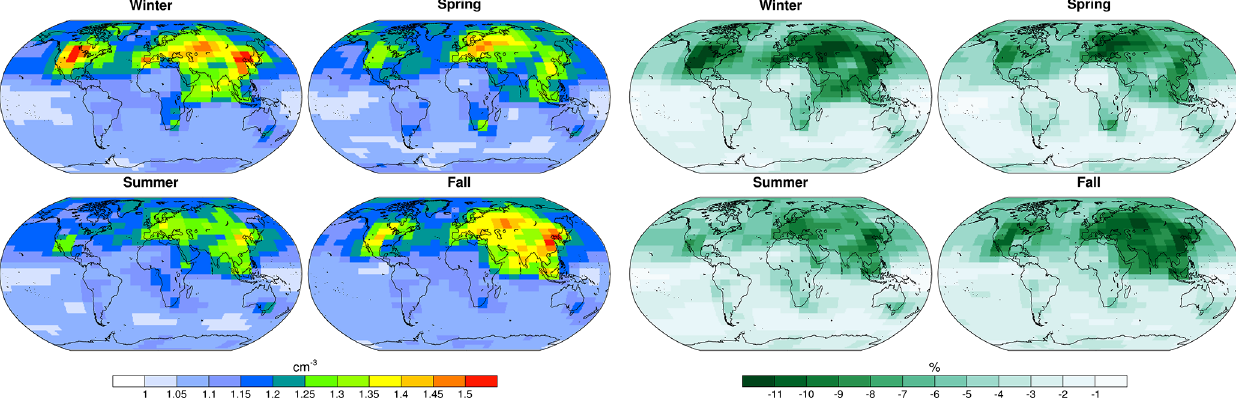
remains unchanged these CDNC increases are easily con- verted into droplet radius